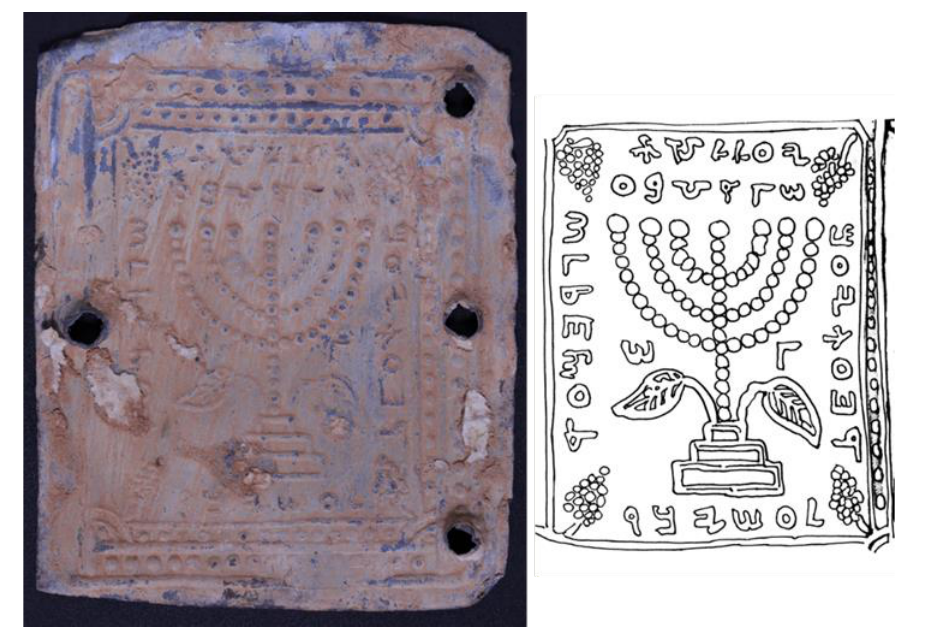
Figure 1. Bar Kokhba silver Shekel (134/5 CE). Obverse: the Jewish Temple facade with the rising star, surrounded by [ ןועמש ] (“Shimon”). Reverse: a lulav and etrog, the text reads: [ םלשורי תורחל ] (“to the freedom of Jerusalem”) (the script is palaeo-Hebrew: see Supplementary Materials for more